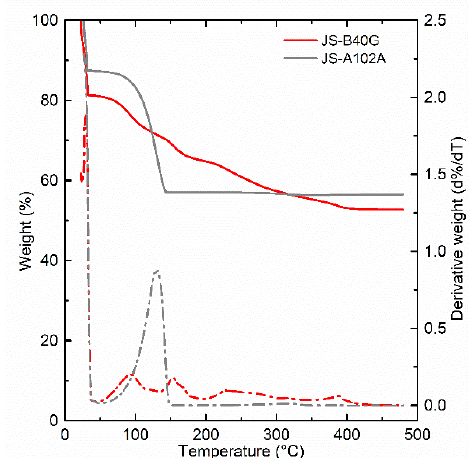
Figure 6. NIR compatibility of JS-B40G and JS-A102A ink. Blue: Specified spectral radiation (kW/µm) of the Adphos NIR light source. Grey: UV-Vis measurement, representing normalized absorbance of JS-B40G ink (light grey), having a low absorption overlap with the lamp and JS-A102A (dark grey), with a high absorption overlap with the lamp.